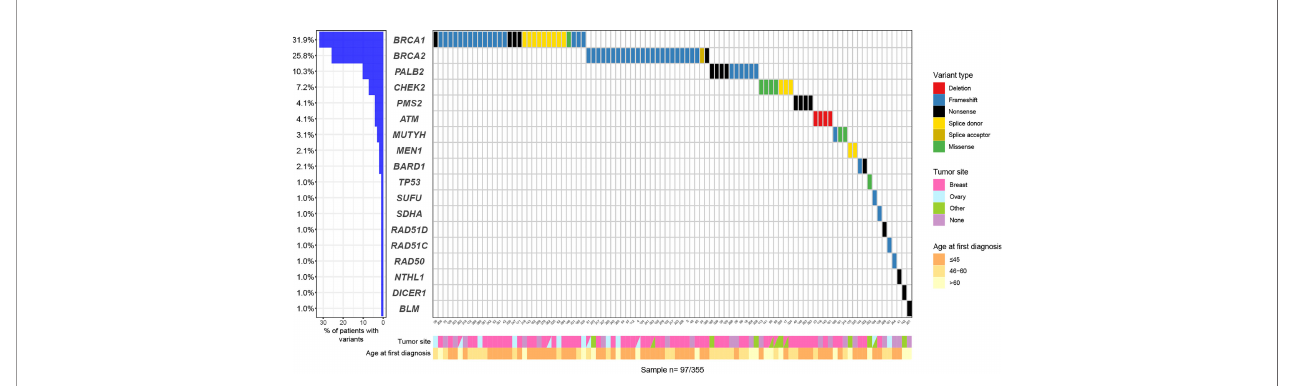
FIGURE 2 | P/LP variants per gene in